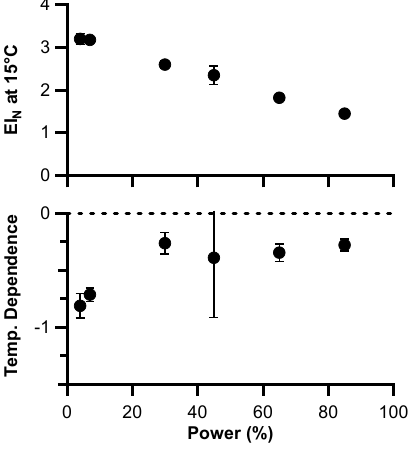
Fig. 9. Aerosol number emission index at 15 ◦ C (10 16 particleskg − 1 ) and its temperature dependence (10 14 particleskg − 1 ◦ C − 1 ) as a function of power as mea- sured at the 30m probe behind the #2 engine. Error bars are the one-sigma standard deviation of the linear fits and may be below the figure resolution. The temperature dependence for 45% has a large error because the #2 engine was not routinely sampled at this engine power. Data are solely from the #2 engine.